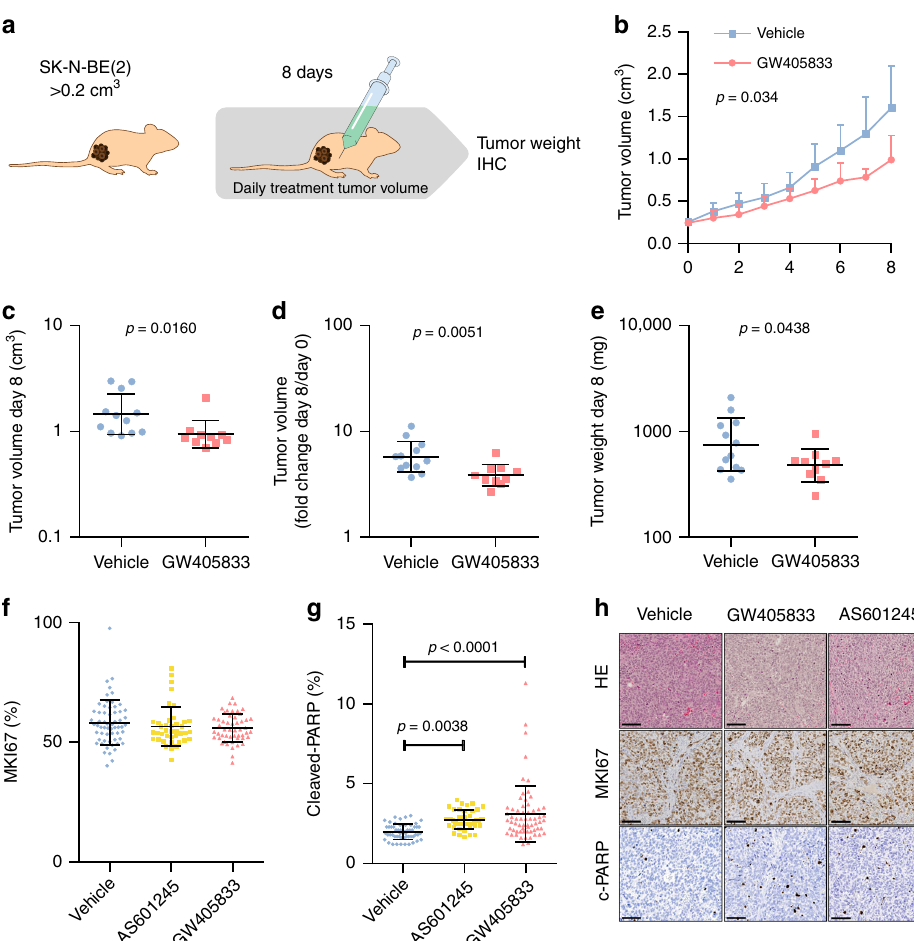
Fig. 7 GW405833 reduces neuroblastoma growth in vivo. a Mice were engrafted with 15 ´ 10 6 SK-N-BE(2) cells s.c. and randomized to receive a daily i.p. injection of GW (45 mg/kg; n = 10) or vehicle ( n = 12) for 8 days, starting at the appearance of palpable tumours of > 0 : 2 cm 3 . b GW405833 signi fi cantly impaired the growth of established human tumours (hierarchical linear model). c Point comparison of day 8 tumour volume. d Tumour volume increase from day 0 to day 8. e Post-mortem tumour weight after 8 days of treatment. f Cell proliferation marker MKI67, counted using ImmunoRatio plugin for ImageJ from 10 to 15 representative fi elds per specimen (DMSO, GW405833, n = 5; AS601245, n = 4). g Apoptosis marker cleaved PARP, counted in using ImmunoRatio plugin for ImageJ from 10 to 15 representative fi elds per specimen (DMSO, GW405833, n = 5; AS601245, n = 3). h Representative images of tumour histology (HE), MKI67 and c-PARP localization, bar = 100 μ m. Statistics: b Mean, 95% con fi dence interval, p -value computed from a mixed effects model and corrected for multiple testing using bonferroni correction. c – g Mean, standard deviation, Student ’ s t